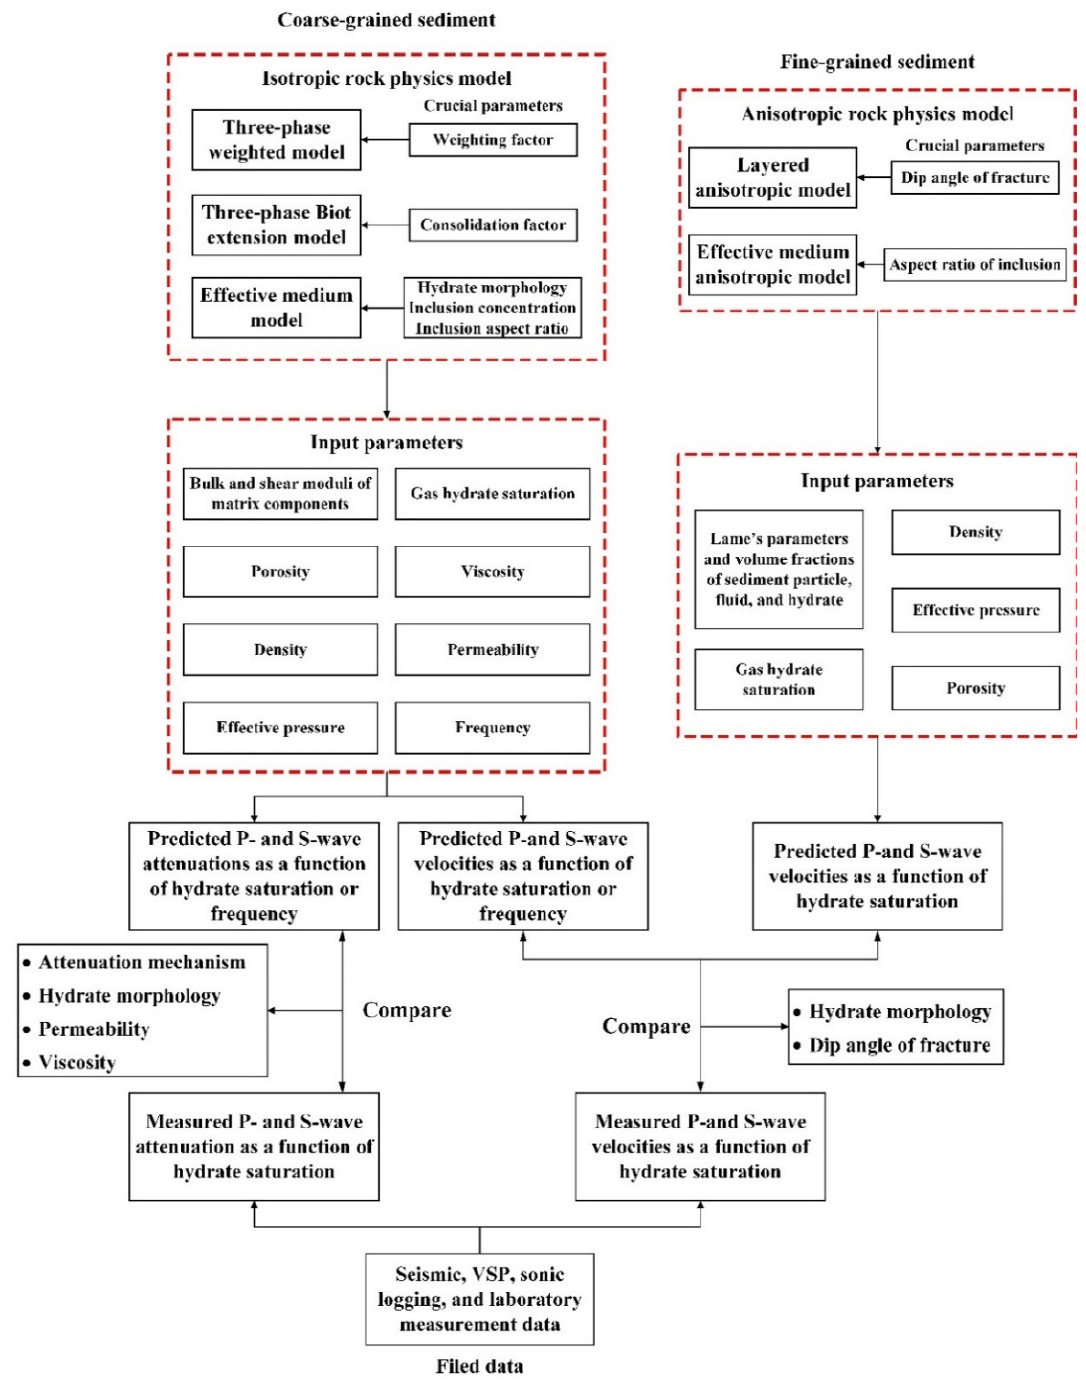
Figure 9. Workflow of rock physics modeling for acoustic properties of GHBS. Varying the dip angle of fracture in the layered anisotropic model from 0 ◦ to 90 ◦ , sediment velocities are estimated and then compared with those predicted by field investigations. Consequently, the dominated dip angle of fracture in the sediment can be determined by the comparison. Anisotropic modeling for the sonic P-wave velocities in the Ulleung Basin of the East Sea of Korea shows the presence of hydrate-filled fracture with a dip angle of 7 ◦ at the upper layer and high-angle fracture at the lower layer [124]. Lee and Collett [125] suggested the P-wave velocity predicted by the layered anisotropic model is insensitive to fracture angle, whereas S-wave velocity is sensitive to fracture